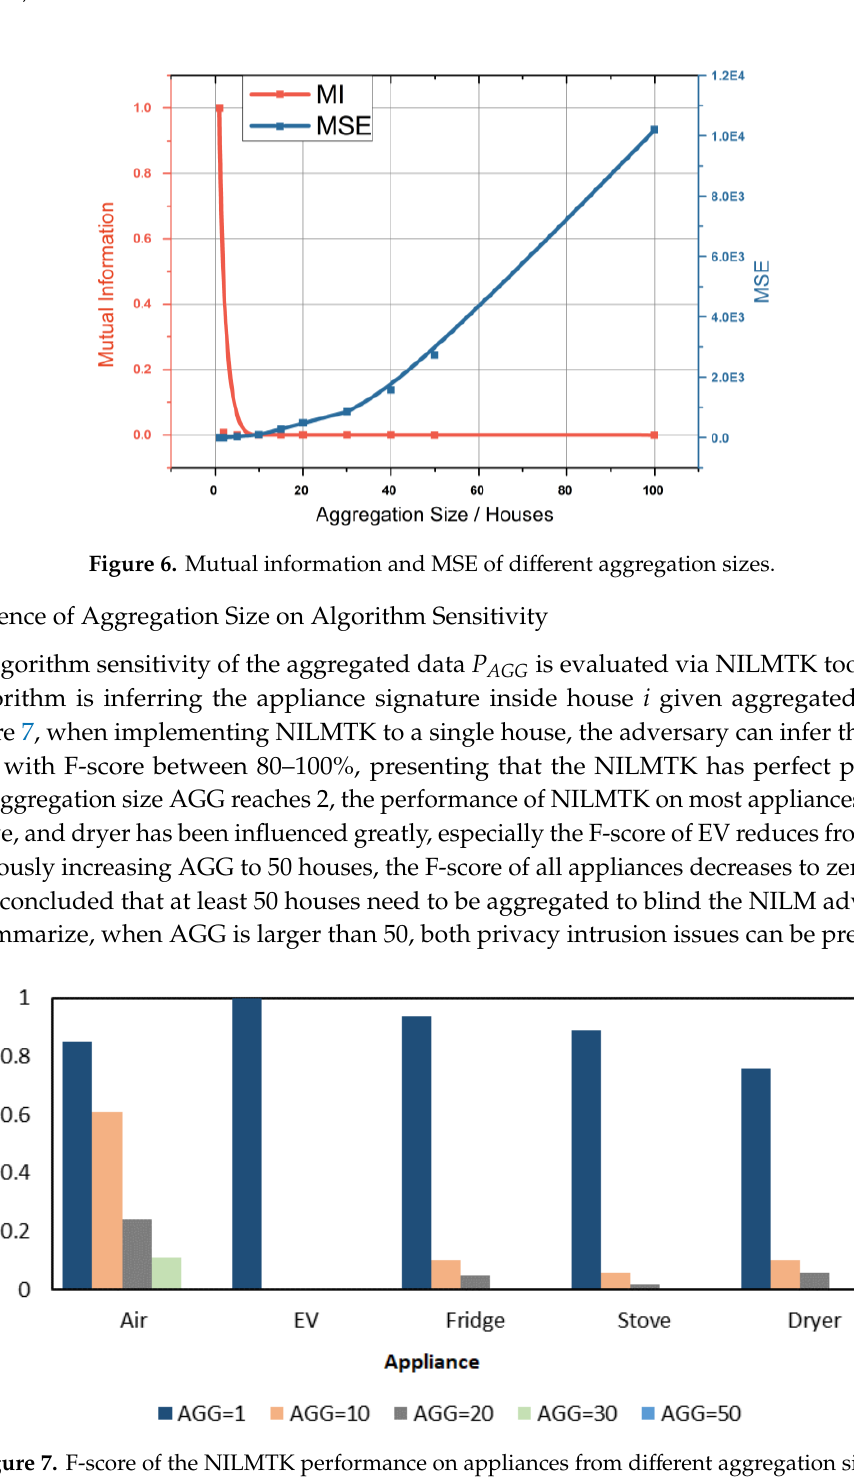
Figure 7. F-score of the NILMTK performance on appliances from different aggregation sizes.